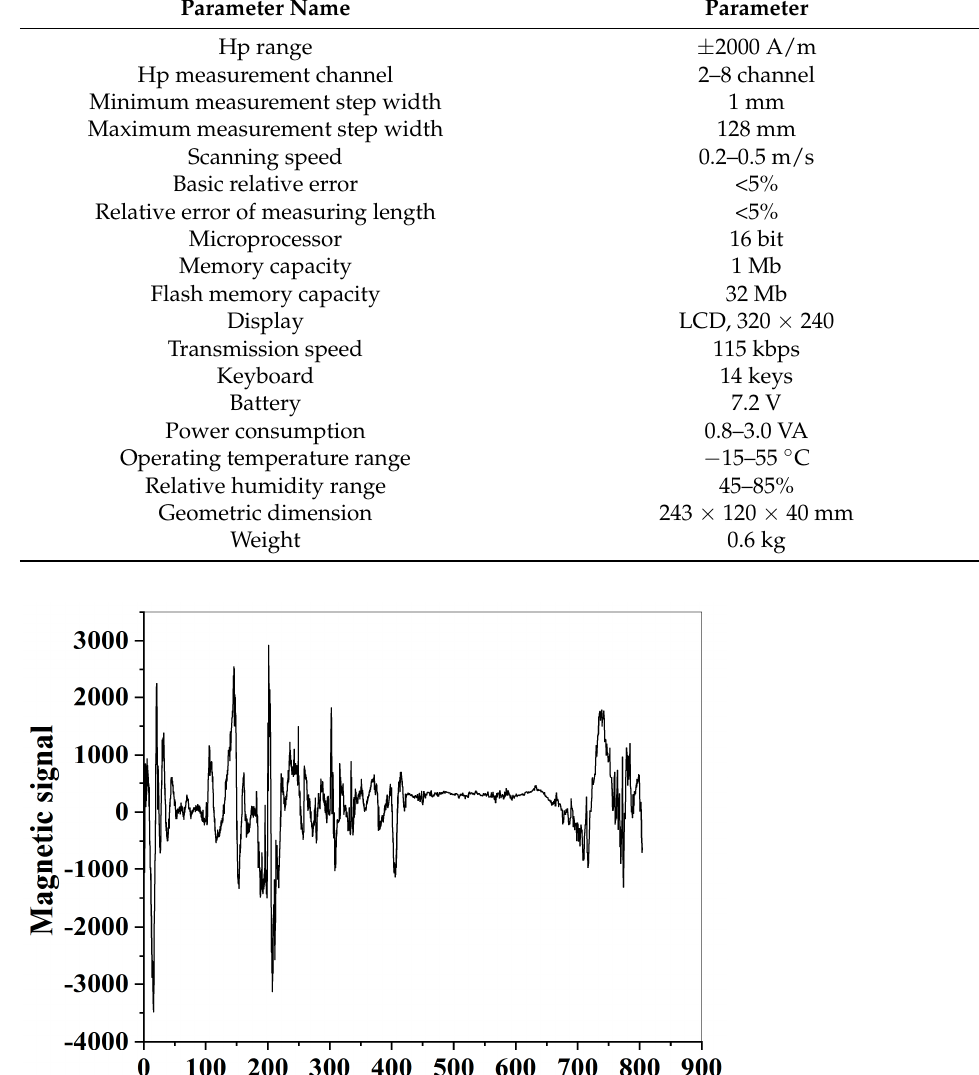
Table 2. Technical parameters of tsc (Triaxial Stress Concentration)-2 m-8 tester.